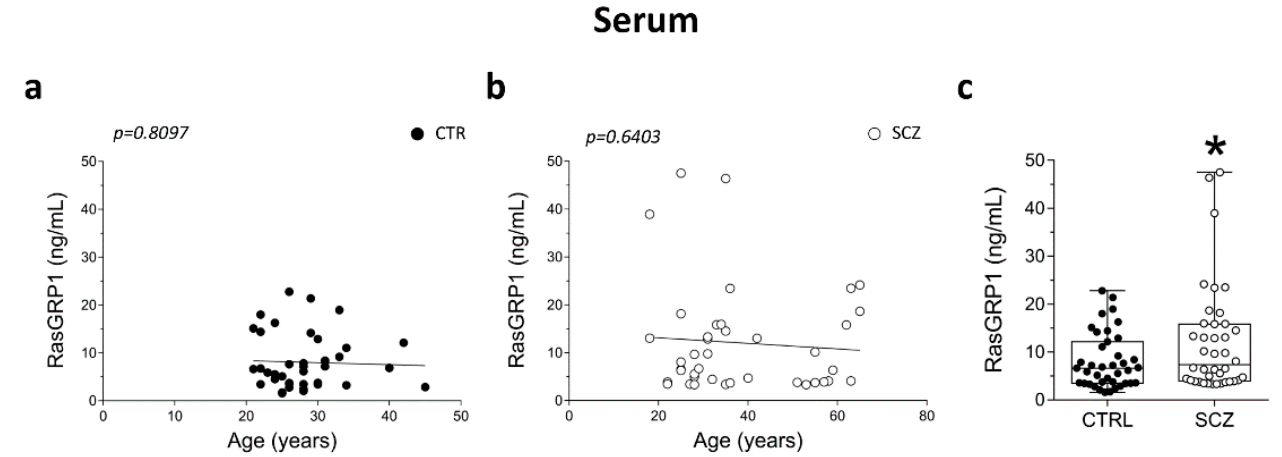
Figure 5. Detection of RasGRP1 protein concentration in the serum of healthy controls and schizophrenia patients. Anal- ysis of correlation between age and RasGRP1 serum concentration of ( a ) control subjects (CTR, n = 39) and ( b ) SCZ patients (SCZ, n = 40). Analysis of ( c ) RasGRP1 concentration (ng/mL) in serum of SCZ-affected patients (SCZ, n = 40) and control subjects (CTR, 39). * p < 0.05 compared to control group (Unpaired t -test). Multivariable regression analysis was performed against